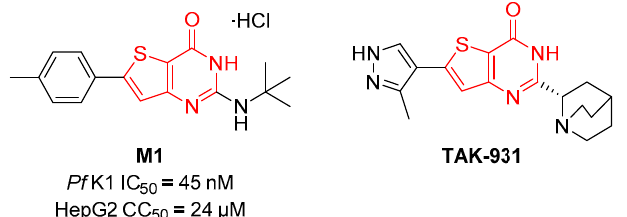
Figure 1. Chemical structures of compounds M1 and TAK-931.